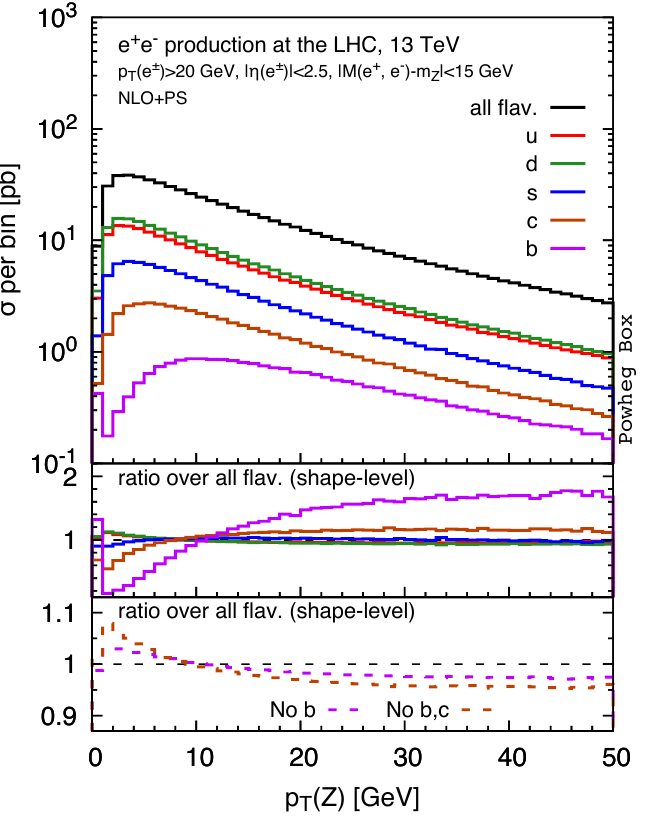
Figure 1 . Flavour decomposition of the p ‘ + ‘ (cid:0) quarks in the